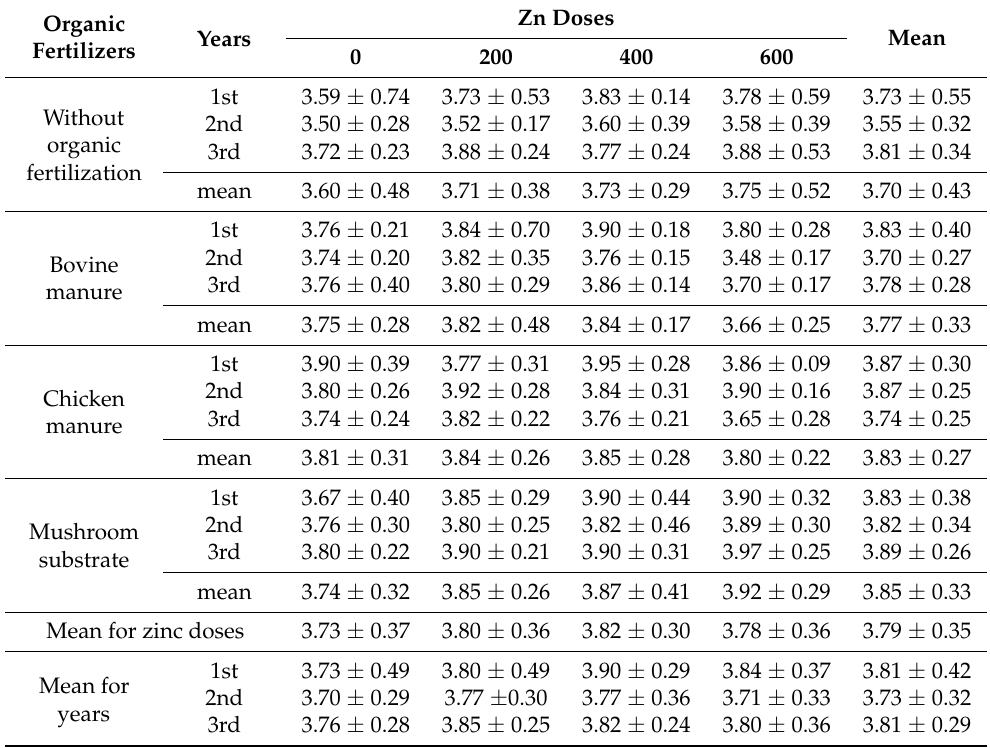
Table 2. Phosphorus content (P g · kg − 1 DM) in cocksfoot under different zinc doses (Zn mg · kg − 1 of soil) and organic fertilization (mean ±